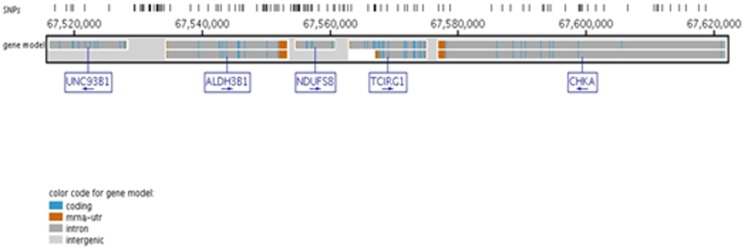
Candidate region targeted for fine-mapping.Using Seattle SNPs genome browser, the candidate genes located within 100TCIRG1 gene, their orientation, and gene structure are displayed. SNPs annotated for these genes are located at the top of the figure denoted by hash marks. (Image generated from http://pga.gs.washington.edu/).